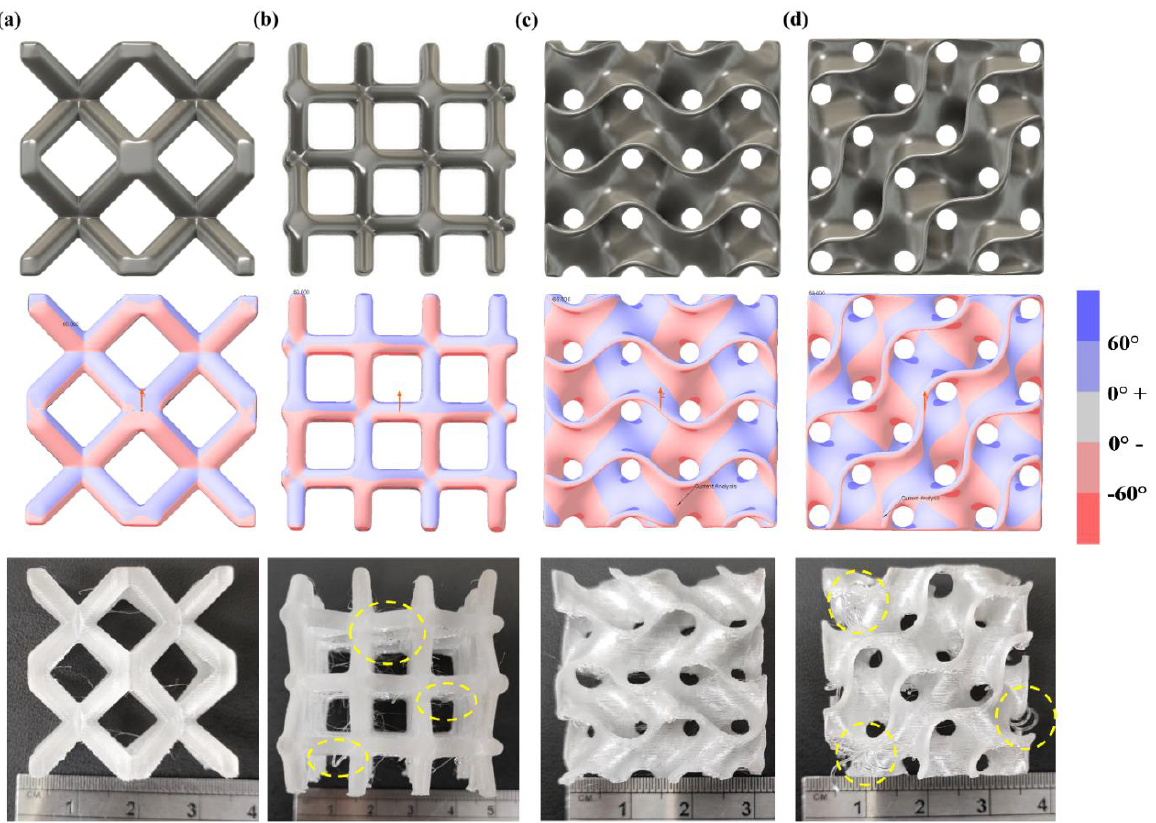
Figure 3. CAD design, draft analysis and additive manufacturing of BCC lattice structure in ( a ) 0° orientation and ( b ) 45° orientation and Gyroid lattice structure in ( c ) 0° orientation and ( d ) 45° orientation.